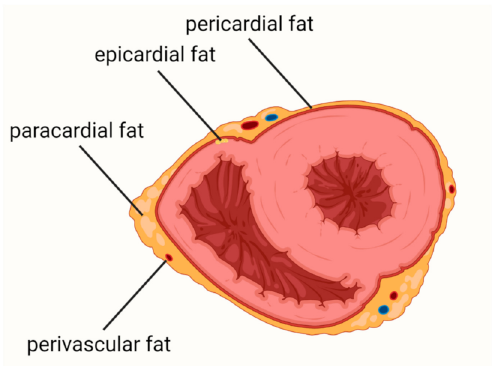
Figure 1. Adipose tissue surrounding the